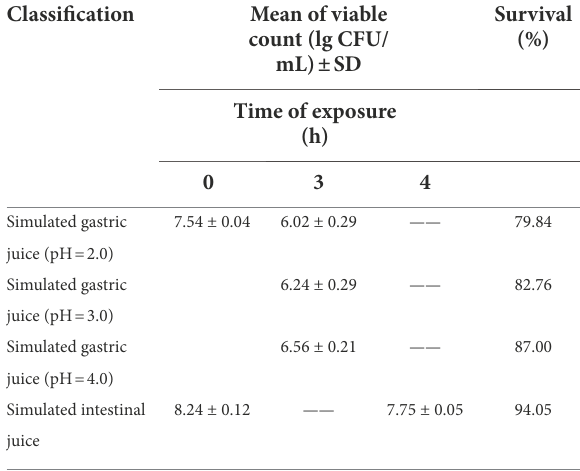
TABLE 5 Effect of L. salivarius S01 on the activity of antioxidant enzymes (SOD, CAT, and POD) and the MDA levels in the S. grahami hepar.